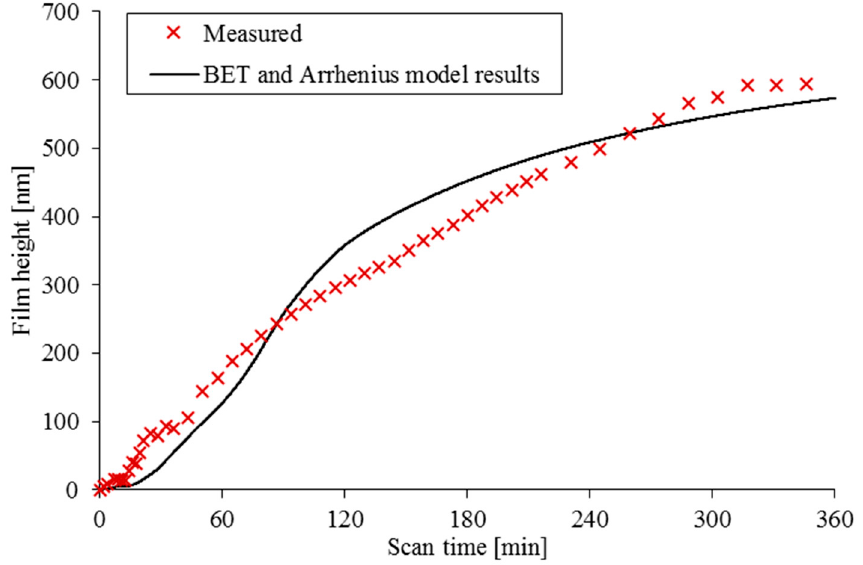
Figure 7. Growth of tribofilm height with time as measured and modelled using the BET adsorption model paired with the Arrhenius shear-promoted thermal activation